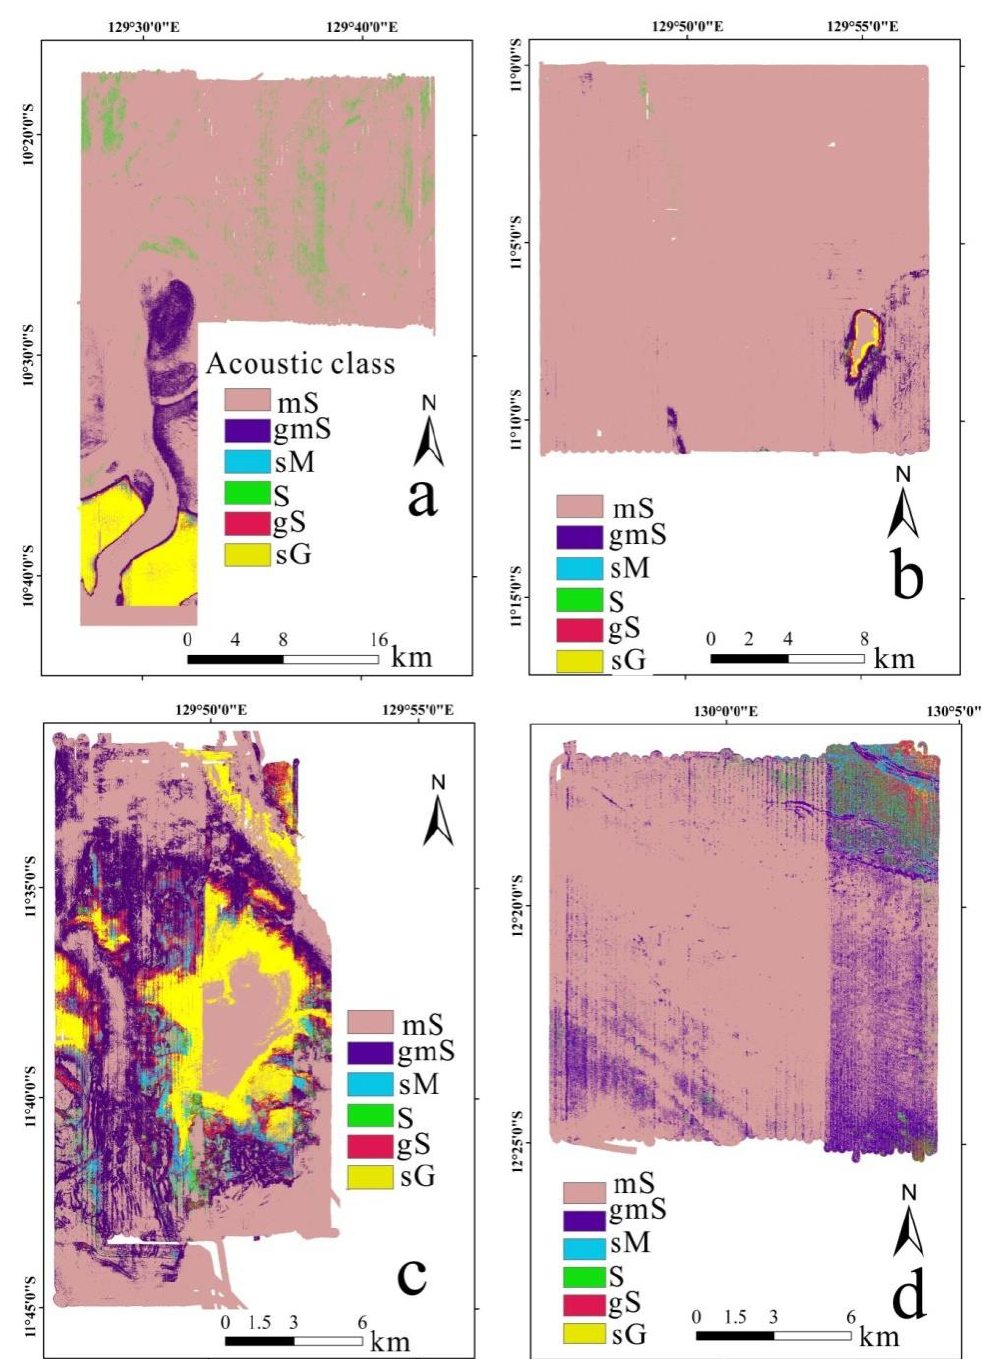
Figure 8. Predicted mapping of acoustic class and the distribution of seabed samples: ( a ), the map of BP_A; ( b ), the map of BP_B; ( c ), the map of BP_C; ( d ), the map of BP_D.